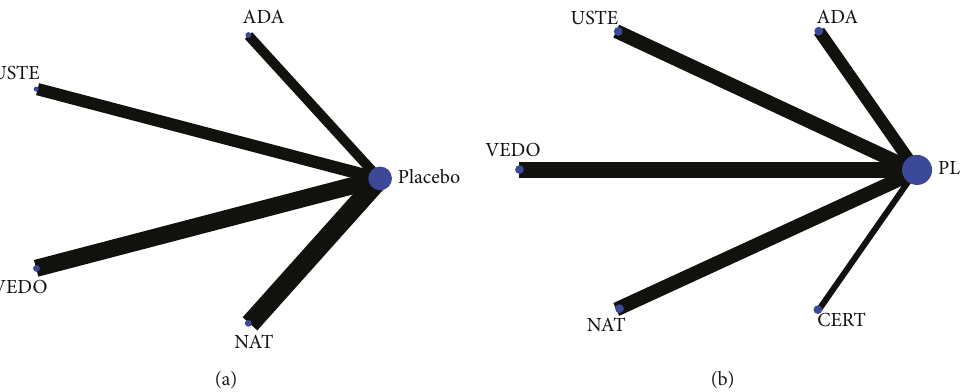
Figure 3: Network diagrams of published studies for induction of remission (a) and response (b) in anti-TNF-experienced CD patients. In brief, circles correspond to each intervention as a node while lines represent the direct comparisons. The size of each circle indicates the number of included participants for each corresponding treatment, and line thickness indicates the number of studies included in each comparison. Placebo as expected is represented by the biggest node. ADA=adalimumab; USTE=ustekinumab; VEDO =vedolizumab; NAT=natalizumab; CERT=certolizumab; PL